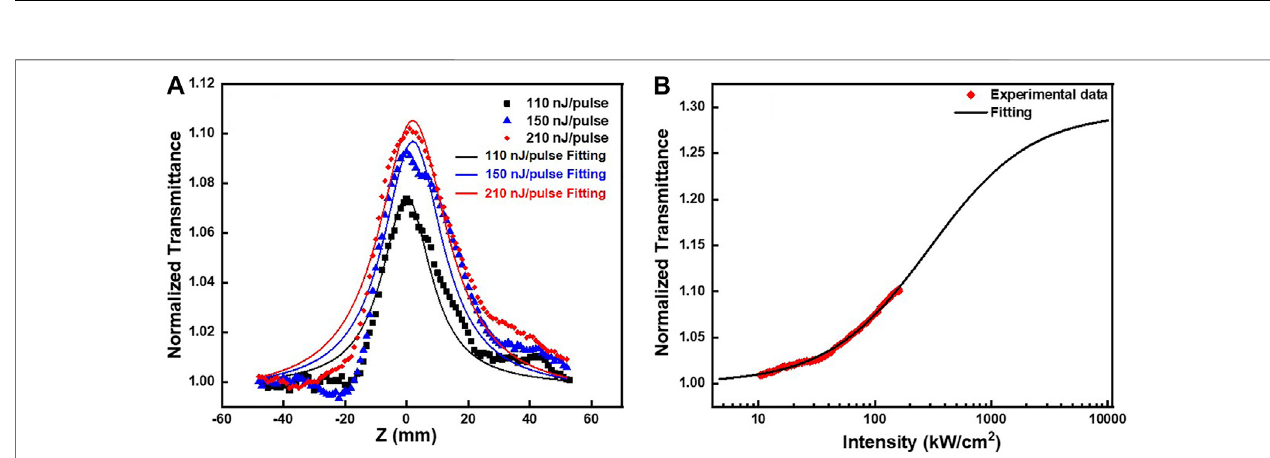
FIGURE 2 | Nonlinear optical characterization of GDY. (A) Open-aperture Z-scan results of GDY nanosheet dispersions at 1,064 nm. (B) Relationship between normalized transmittance of GDY dispersions and input peak intensity.